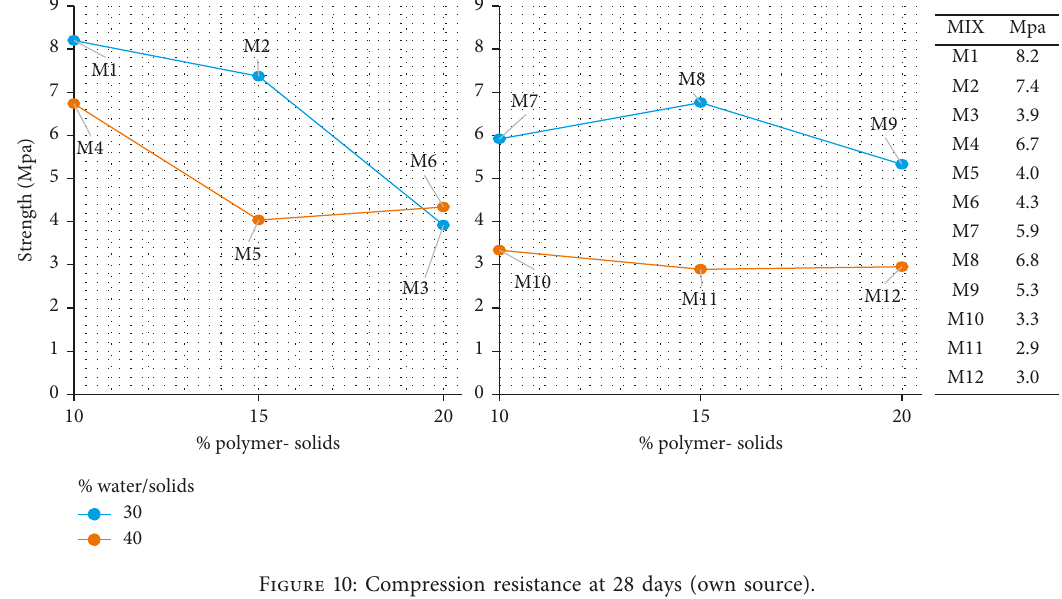
Figure 10: Compression resistance at 28 days (own source).